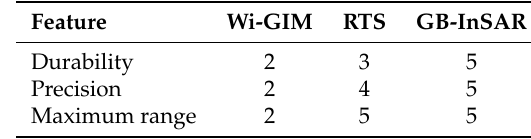
Table 9. Wi-GIM System Limitations with respect to RTS and